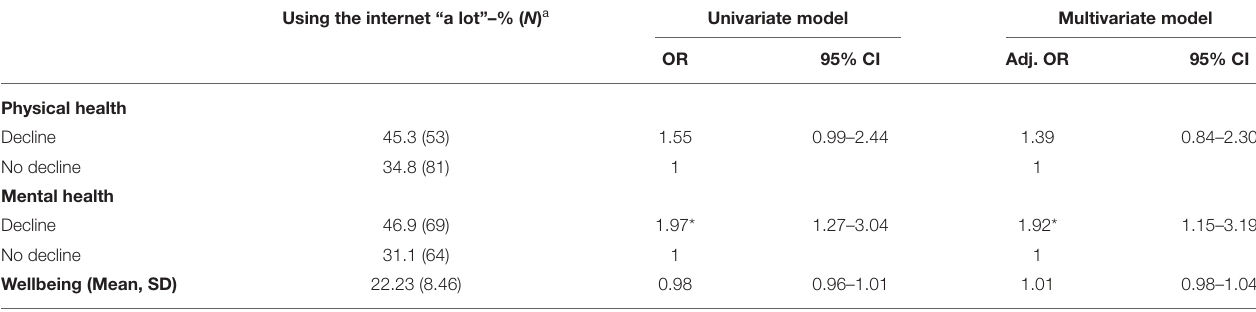
TABLE 4 | Association of health variables with Internet use. Using the internet “a lot”–% ( N ) a